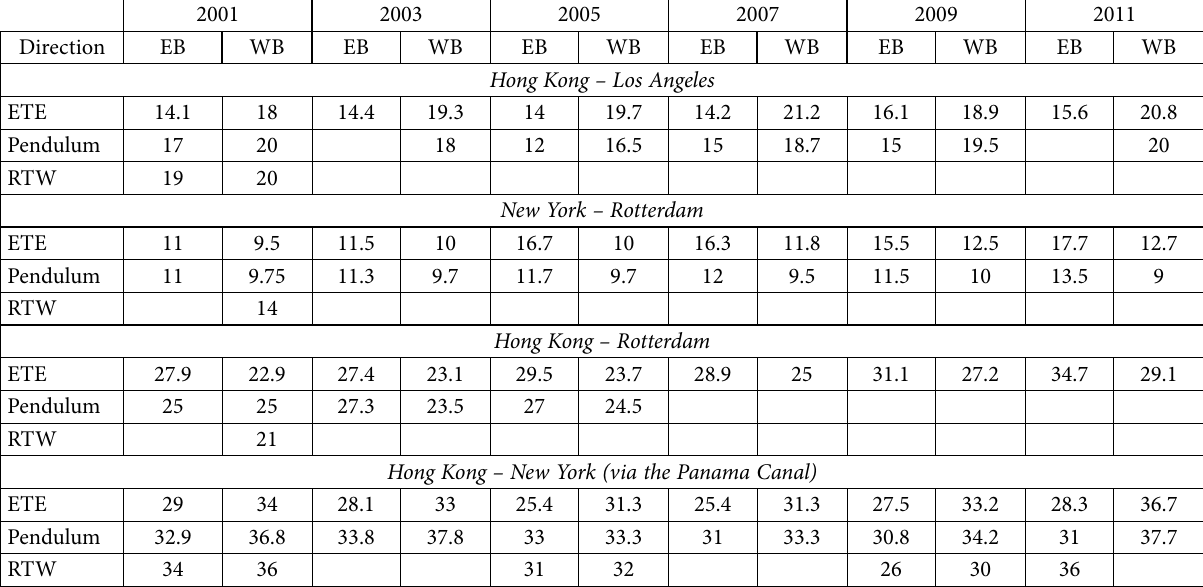
Table 9. Transit time between ports